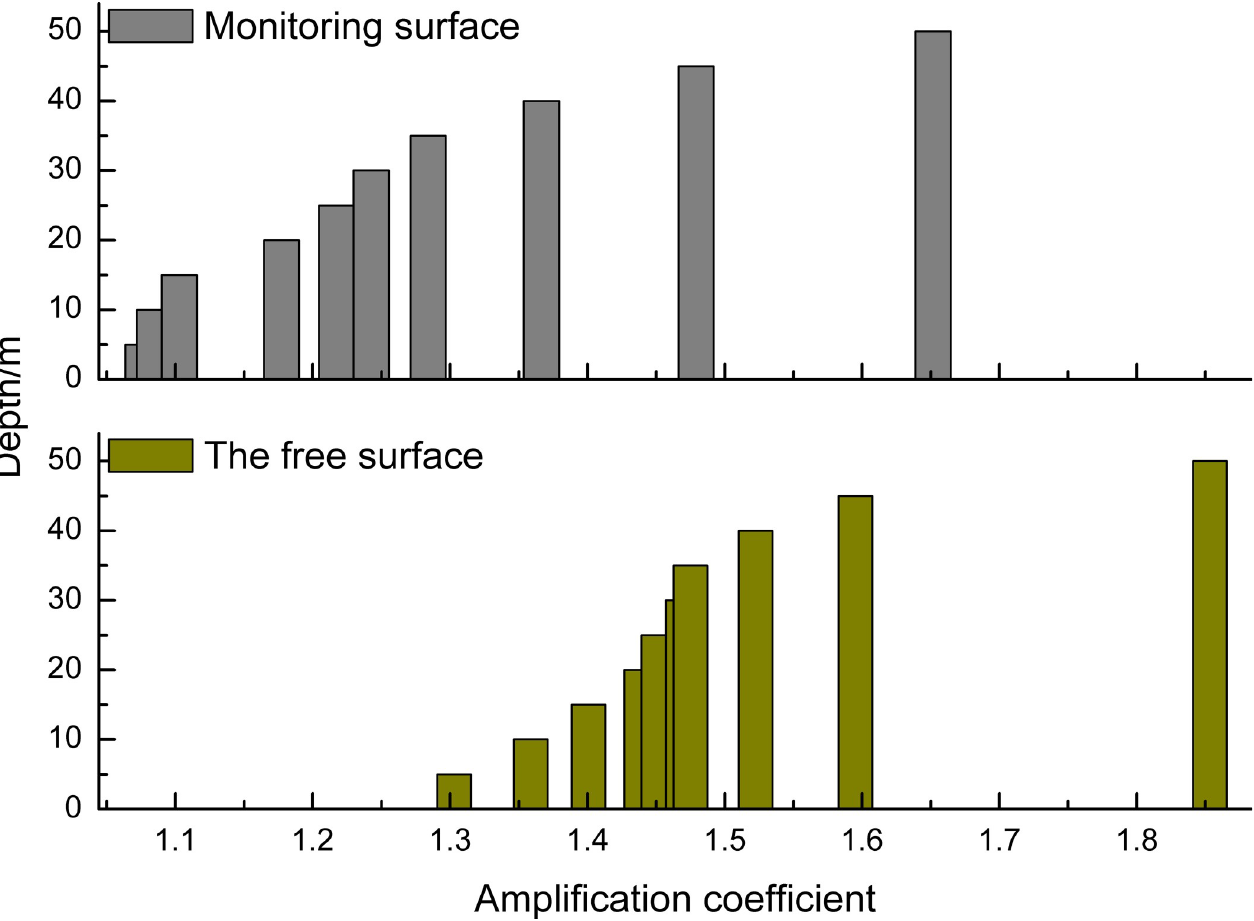
Fig 12. The distribution of the amplification coefficient of peak ground